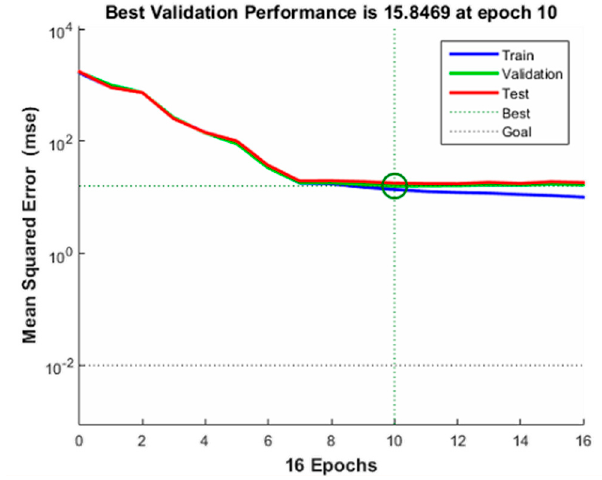
Figure 6. MSE (root mean squared error) analysis of the optimized ANN model.